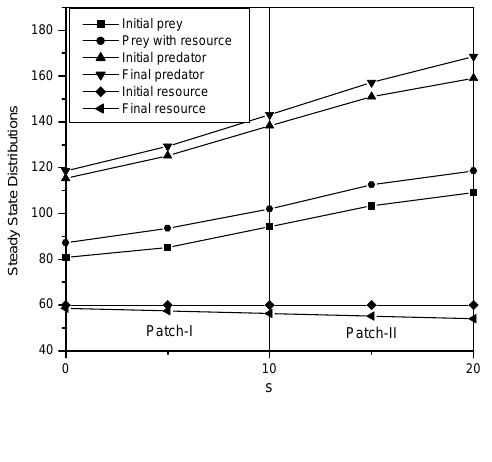
Figure 1. The steady state solutions for both the species, with and without supplementary resource for the